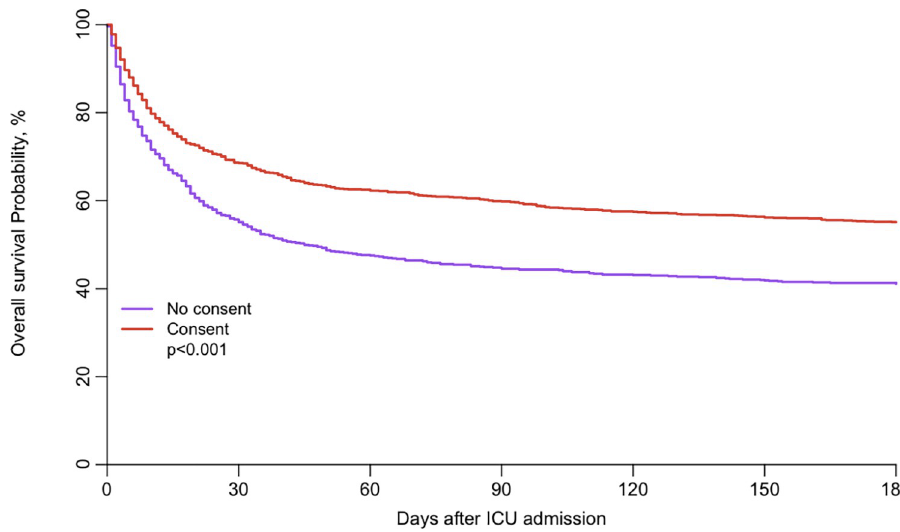
Fig 1. Adjusted survival curve in the consent and no consent groups. (Fig 1 OS-adjusted-consent.tiff).